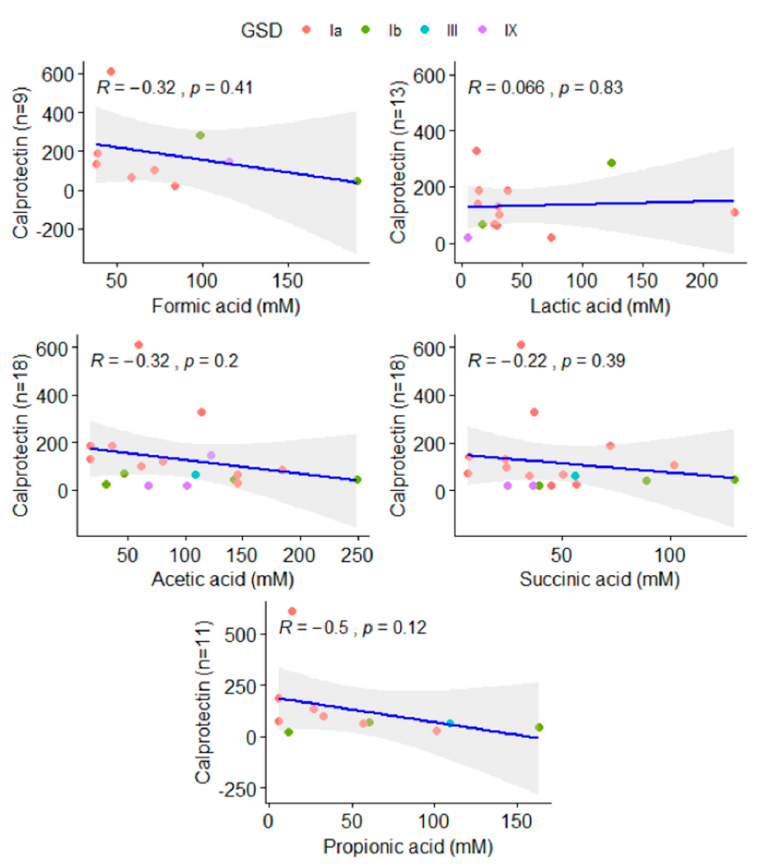
Figure 3. Correlation of acetic, propionic, succinic, lactic, and formic acids and calprotectin levels found in patients. The number of valid reads available in each comparison was added to Y-axis.